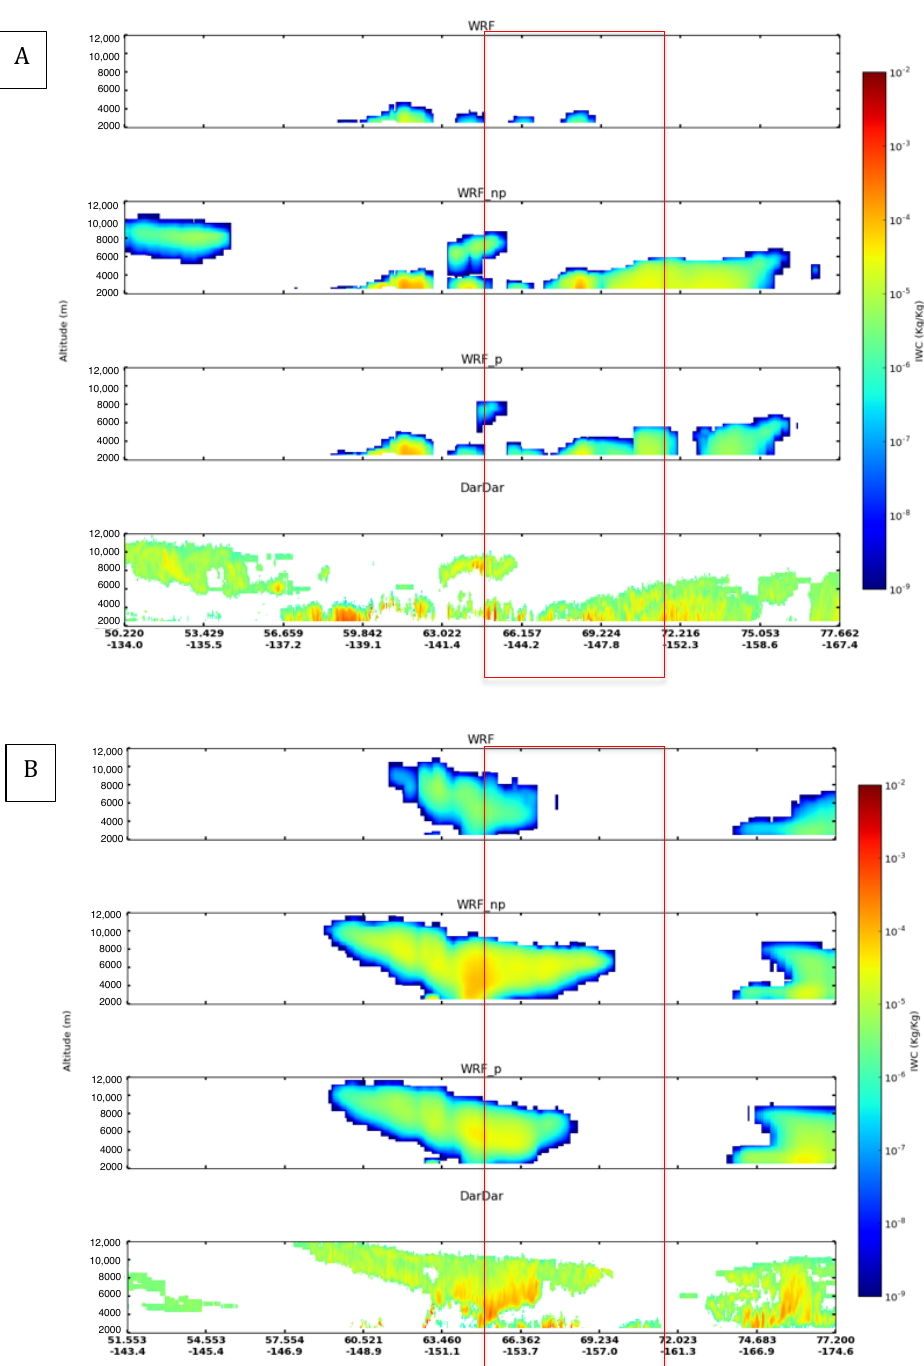
Figure 6. Observed DARDAR and simulated cross section of the ice water content IWC from WRF, WRF_np, WRF_p simulations along T21 ( A ) and T29 ( B ) tracks. The red rectangles correspond to the whole area where the flights have been performed (Figure